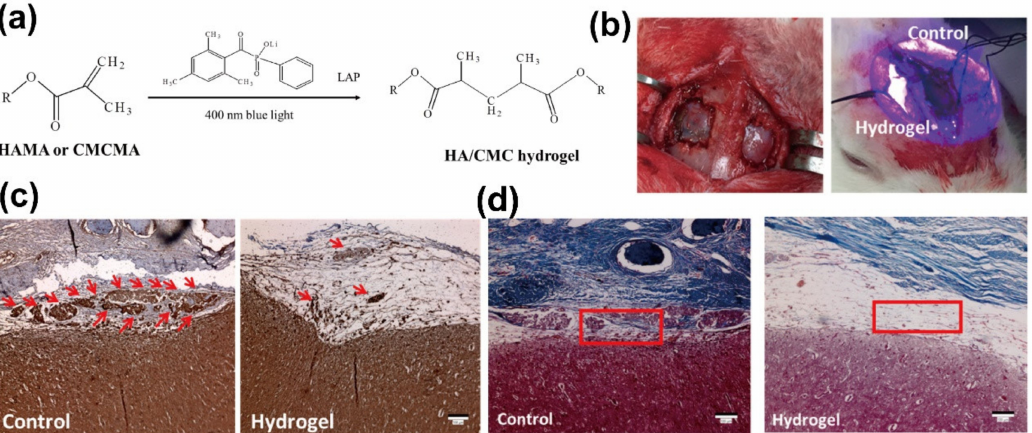
Figure 8. ( a ) Diagram of HA/CMC hydrogel synthesis using the photocrosslinking reactions. ( b ) The bilateral defects were established on the rabbit’s skull; one defect was treated with hydrogel, and the other was not treated. ( c ) The immunohistochemical staining of vimentin (red arrows mean fibroblasts synthesized vimentin) and ( d ) the H and E staining image in adhesion tissue of the control group and hydrogel group, bar = 100 µ m. Reprinted with permission from Ref. [169]. Copyright 2022 The